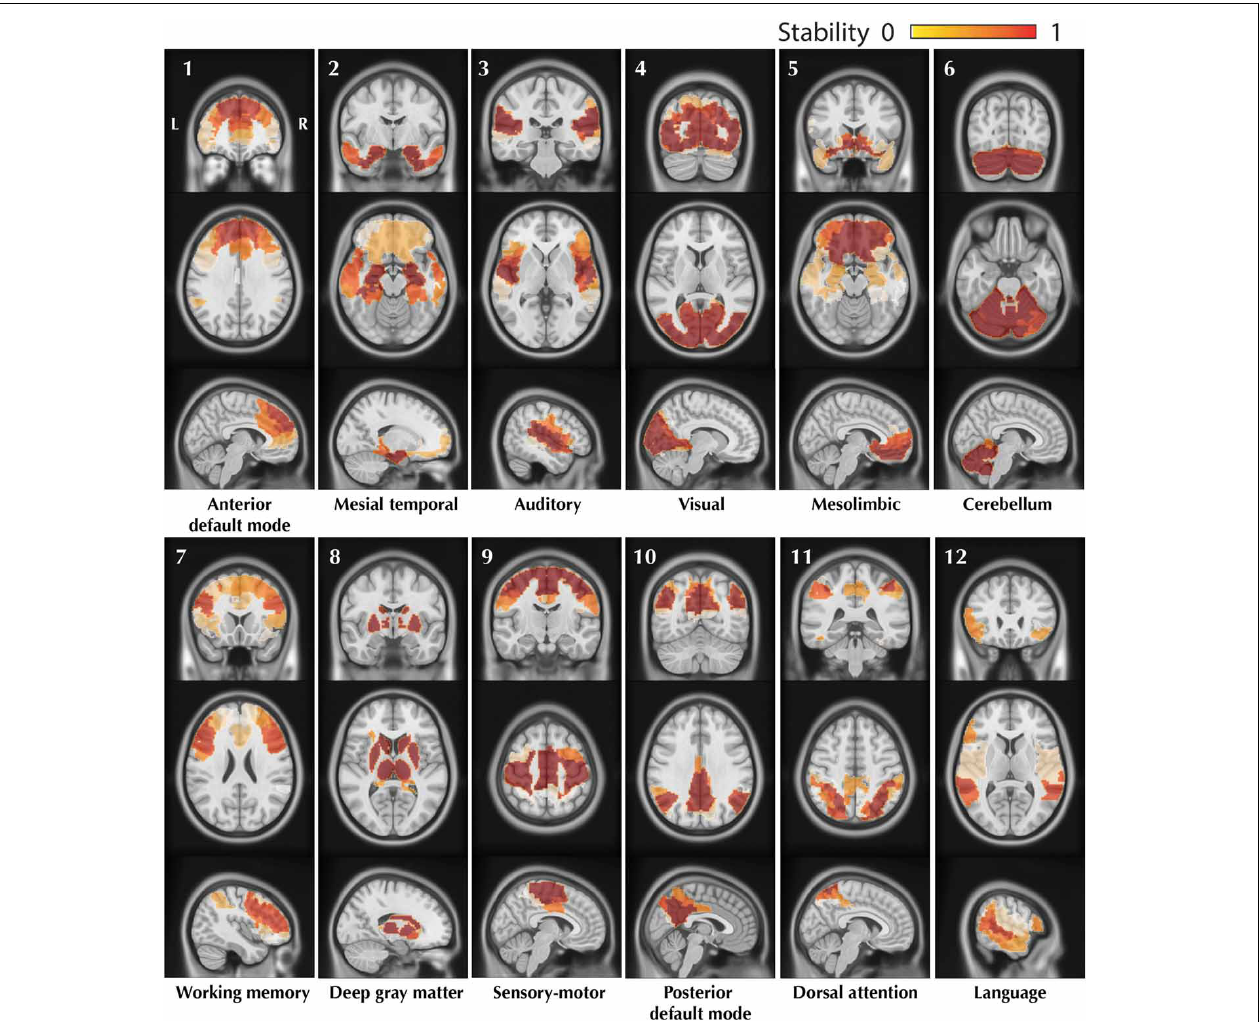
FIGURE 4 | Visual representation of the 12 CRSNs identified using BASC group level analysis of 25 healthy control subjects. For each CRSN: 3 slices (coronal, axial, sagittal) are shown superimposed on an anatomical MRI template (MNI152). Labeling of each network was done visually based on previously reported CRSNs in the literature. The figure shows the usual